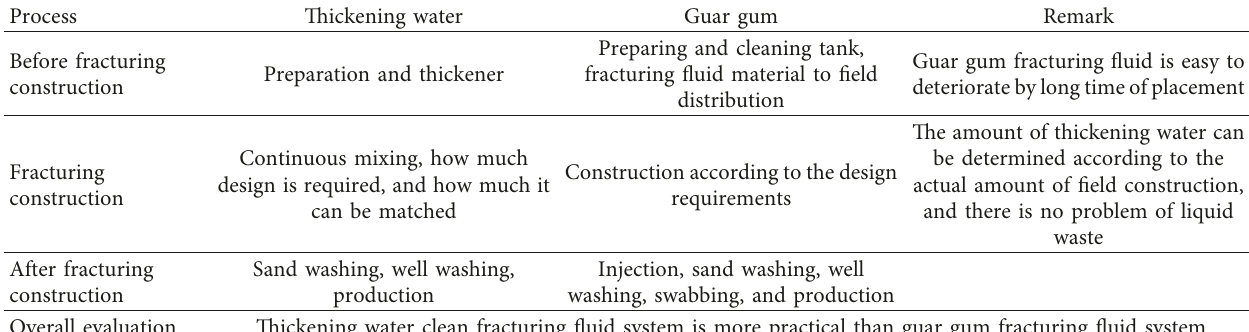
Table 5: Comparison of construction process.